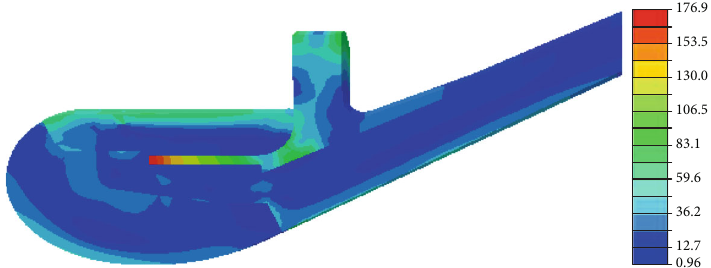
Figure 9: Von Mises stress distribution of submerged nozzle at 28 s under thermal loading and pressure,